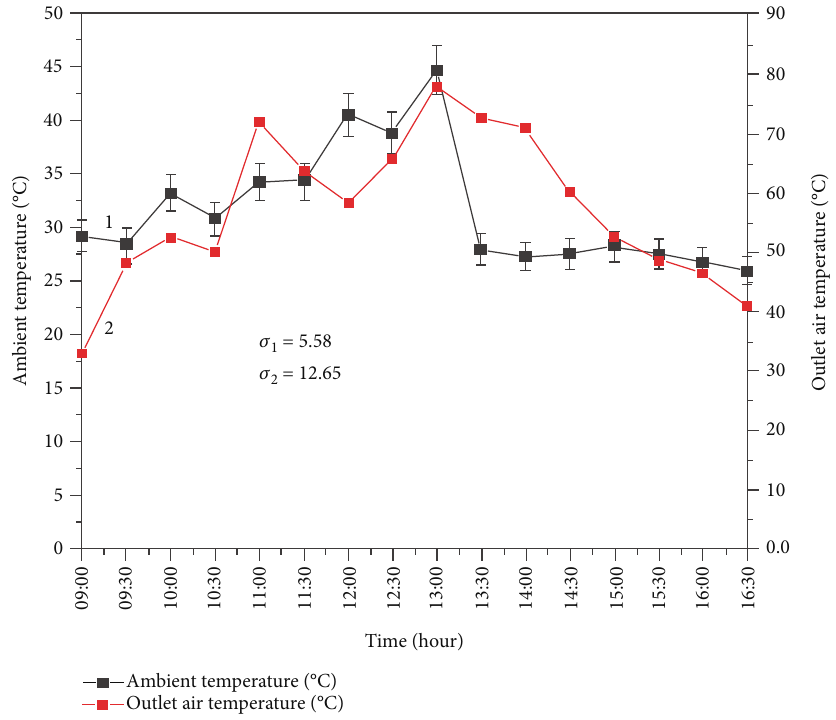
Figure 12: The ambient and outlet air temperatures for the